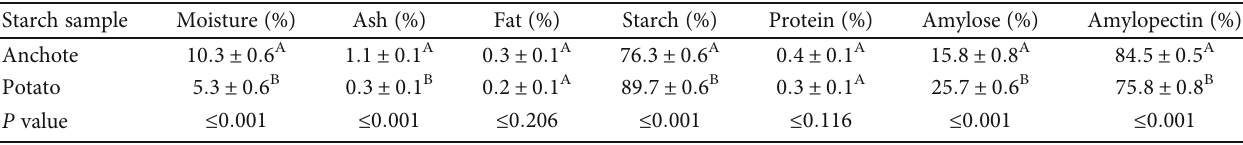
Table 2: Proximate composition and amylase and amylopectin contents of starch from anchote and potato tubers. Starch